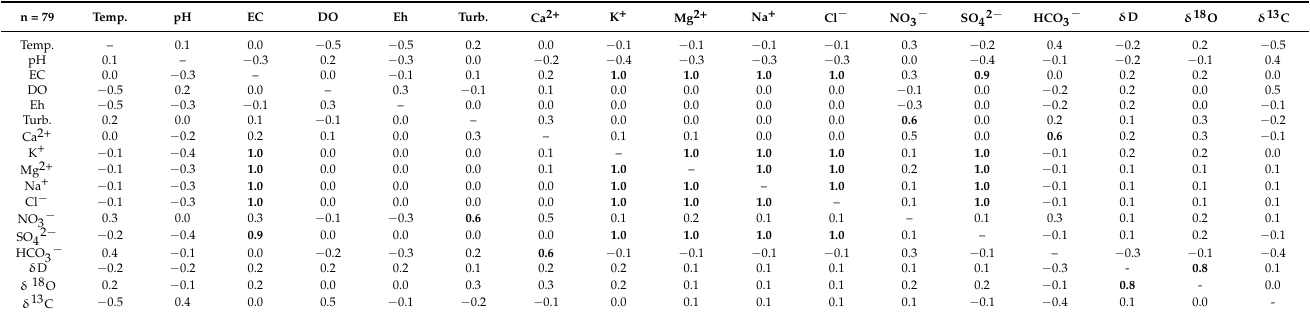
Table 2. Correlation analysis of surface water parameters in Samcheok. Values exceeding 0.6 are